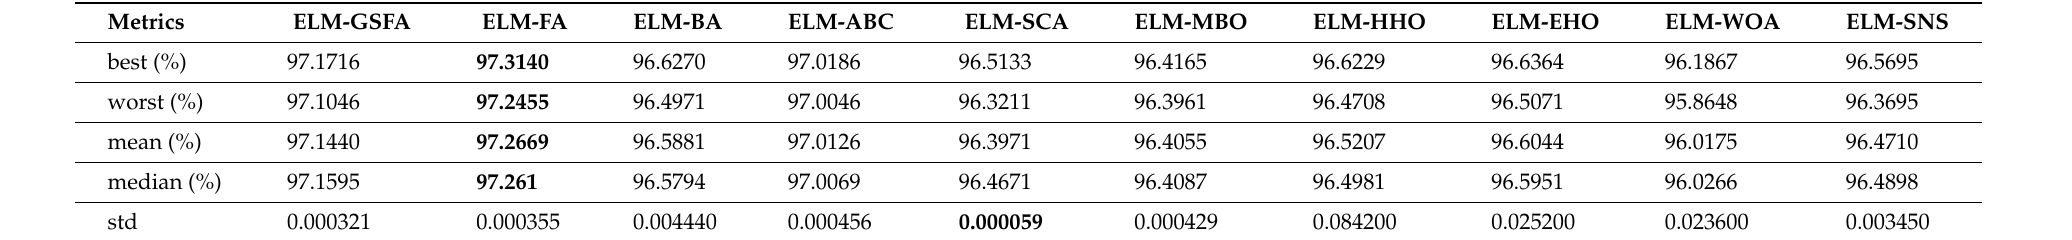
Table 6. ELM Credit Card Fraud with the SMOTE—general metrics.